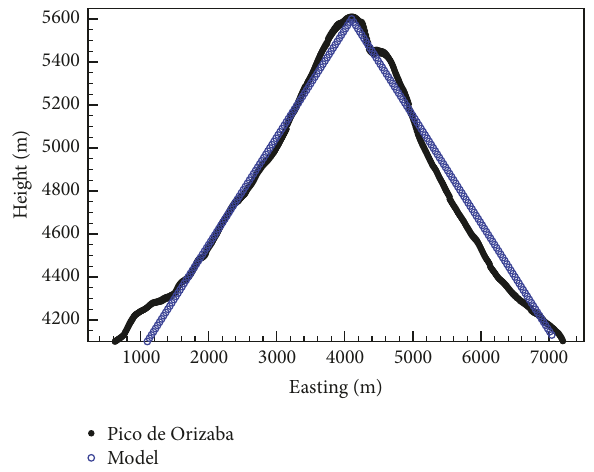
Figure 4: Projection of the Pico de Orizaba profile along the Easting axis. The blue open markers show the profile of the conical approximation to the volcano, while the black closed circles indicate the real profile of the volcano.